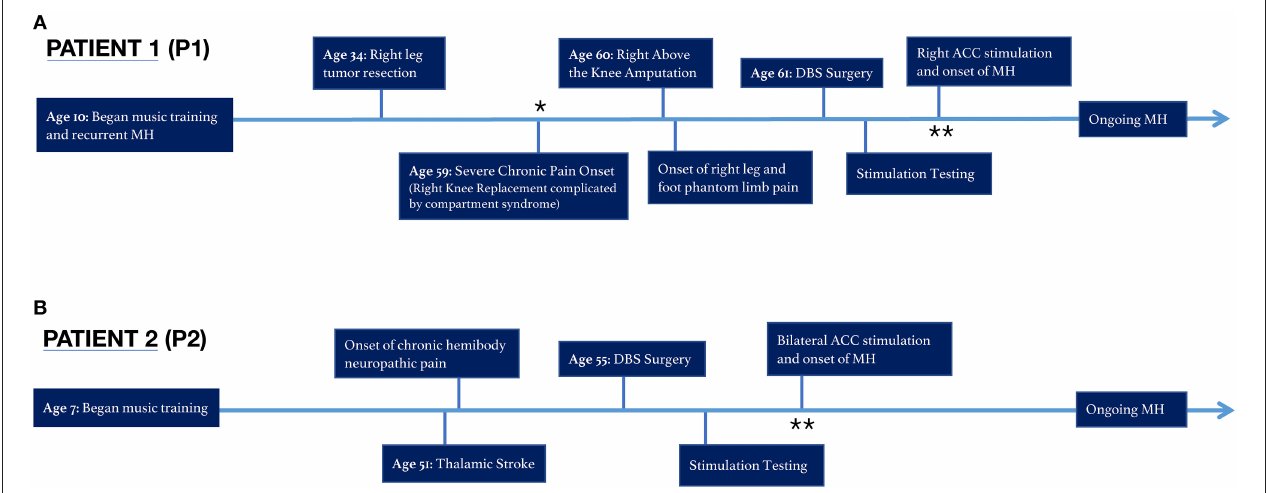
FIGURE 1 | Timeline of chronic pain and musical hallucinations for Patients 1 and 2. (A) Patient 1 (P1) experienced continuous MH throughout her life, until the onset of severe chronic pain at age 59. The MH became less frequent and noticeable until the patient received brain stimulation to the right ACC. (B) Patient 2 (P2) developed MH for the first time during bilateral ACC stimulation. *MH muted, **MH onset.